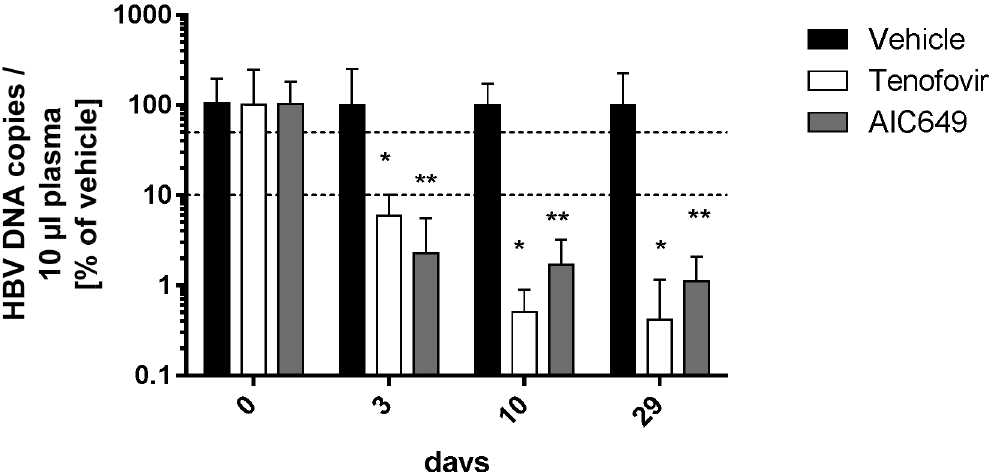
Fig 1. AIC649 reduces the HBV titer in HBV tg mice as effective as Tenofovir. HBV tg mice were treated i.p. with AIC649 (1 x 10 8 viral particles / dose) twice weekly for 9 times in total. Tenofovir was administered twice daily by oral gavage at a total concentration of 100 mg/day. Negative control: Tenofovir vehicle, administration analogous to Tenofovir. Mice were sacrificed at the indicated time points and plasma samples were subjected to HBV DNA determination. HBV titers are expressed in % of the respective negative vehicle group +/- SD. * p < 0.05, ** p < 0.01 (vs respective treatment on day 0).